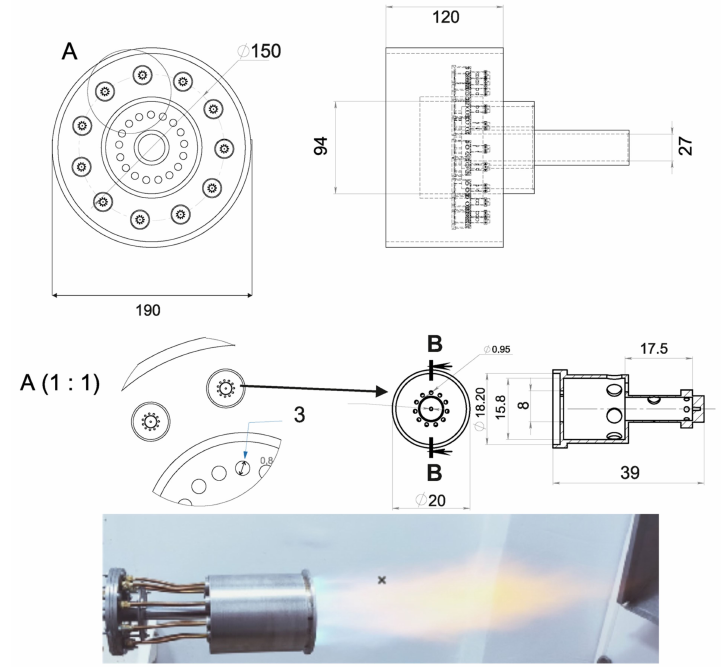
Figure 4. Operation of the gas-thermal